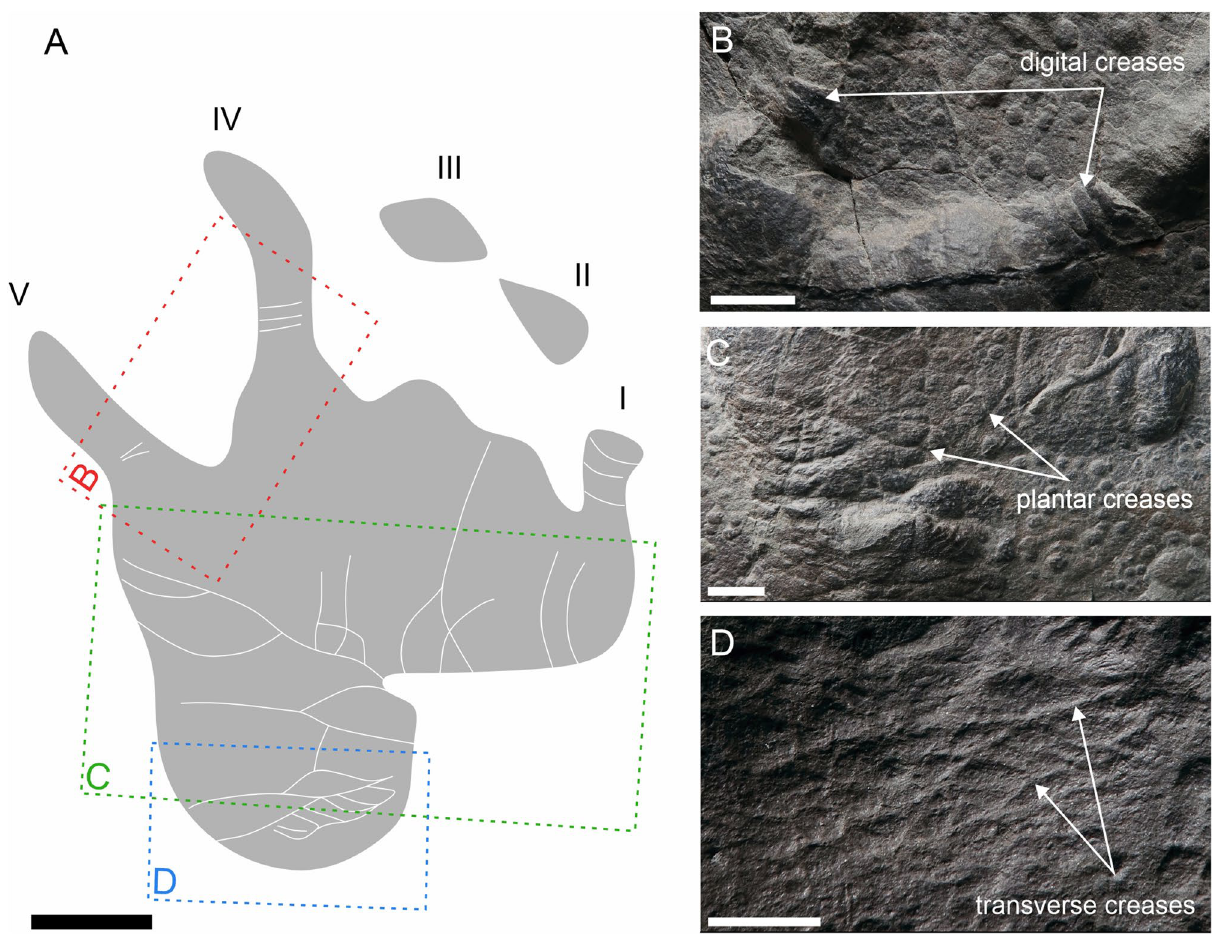
Figure 3. The pes imprint of MZM Ge 29610 with highlighted soft tissue impressions ( A ), including digital ( B ), plantar ( C ), and transverse ( D ) creases. Scale bars: ( A ) 2 cm, ( B – D ) 1 cm.